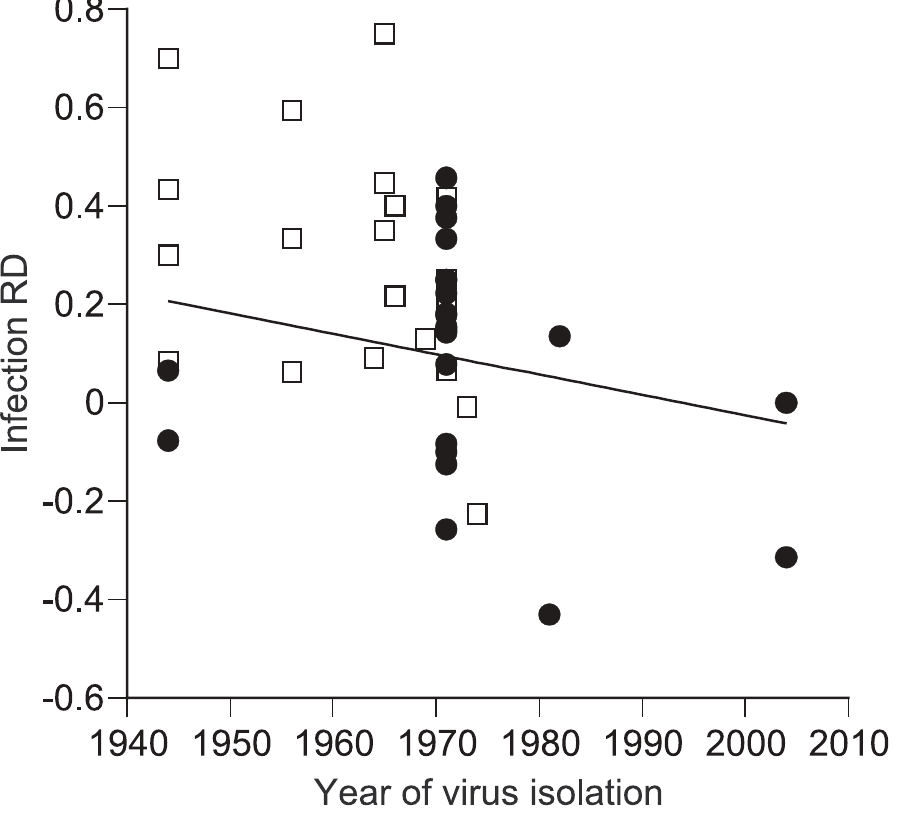
Figure 2. Relationship between RD and virus isolation year among published experiments comparing DENV midgut infection in Ae. albopictus and Ae.aegypti . Each point represents a single experiment. Different symbols indicate a different mosquito colonization history (i.e., number of generations spent in the laboratory before vector competence was assessed). Filled circles represent mosquitoes held # 5 generations in the laboratory; open squares correspond to mosquitoes colonized for . 5 generations. The solid line shows the linear regression (R 2 =0.162, P =0.007). Negative RD values represent a reduced rate whereas positive values represent a greater rate for Ae. albopictus compared to Ae. aegypti .